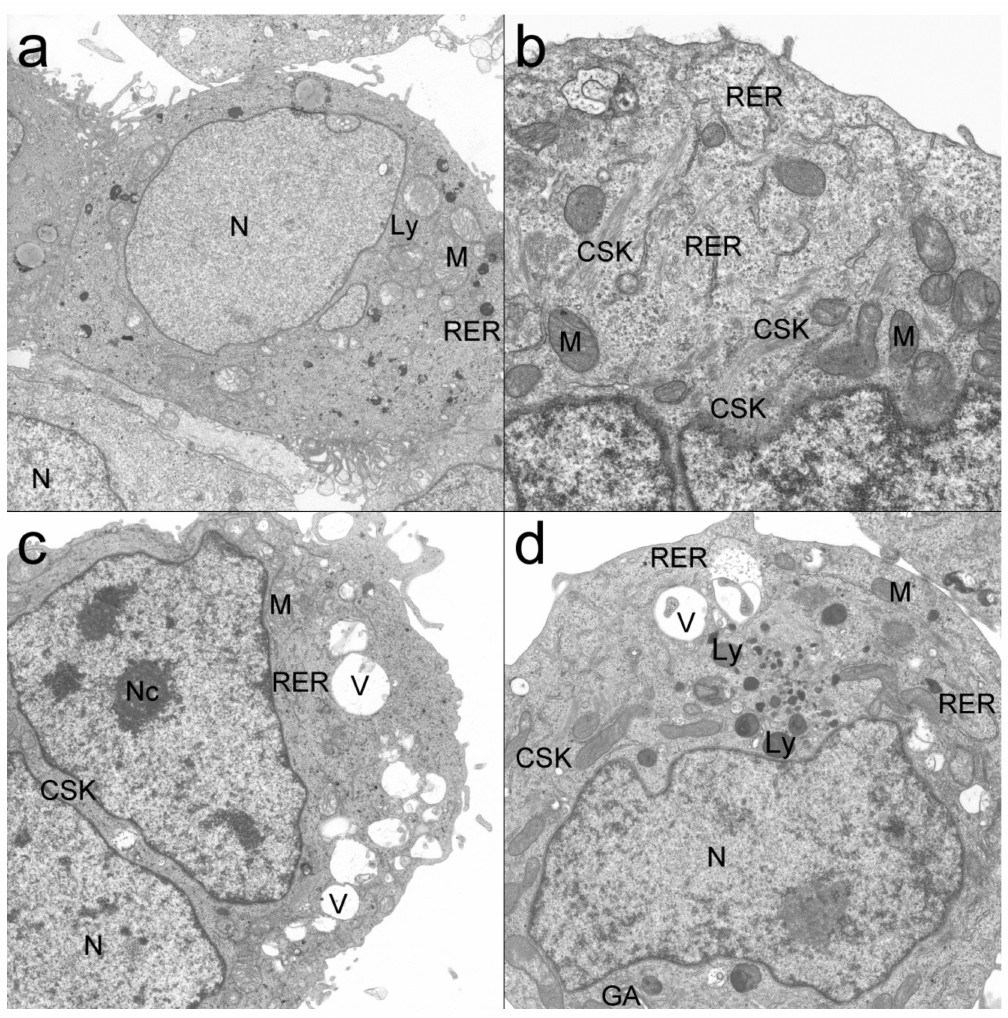
Figure 10. Ultrastructure of breast adenocarcinoma doxorubicin-sensitive cells (MCF-7 / WT). ( a )—Control, nontreatedcells;( b )—Cellsafterexposuretodoxorubicin(DOX = 1.7 µ M ) ;( c )—CellsafterEP(EP = 1000V / cm, 100 µ s, 8 pulses, 1 Hz); ( d )—Cells after ECT with doxorubicin. Abbreviations: CSK—cytoskeleton; GA—Golgi apparatus; Ly—lysosomes; M—mitochondria; N—nucleus; Nc—nucleolus; RER—rough endoplasmic reticulum; V—vacuole; (original magnification 7A × 4400; 7B × 12600; 7C, 7D ×